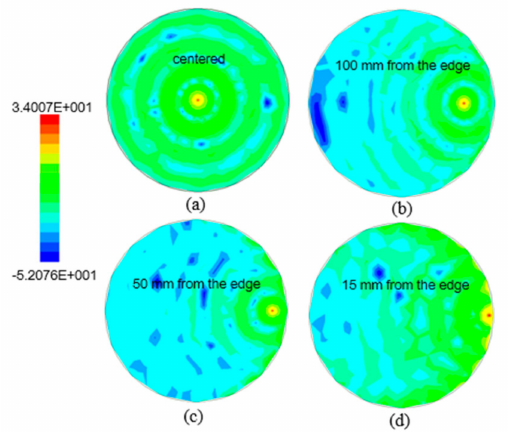
Figure 4. The current distributions on the ground plane in centered and off-centered mounting configurations—( a ) centered, ( b ) 100 mm, ( c ) 50 mm, and ( d ) 15 mm from the right